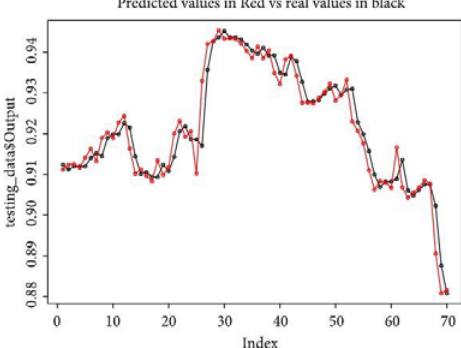
Figure 2 : Predicted values versus real values (predicted values in red, real values in black); for Random Forest regression using: 500 tree and 8 variables tried for each split.